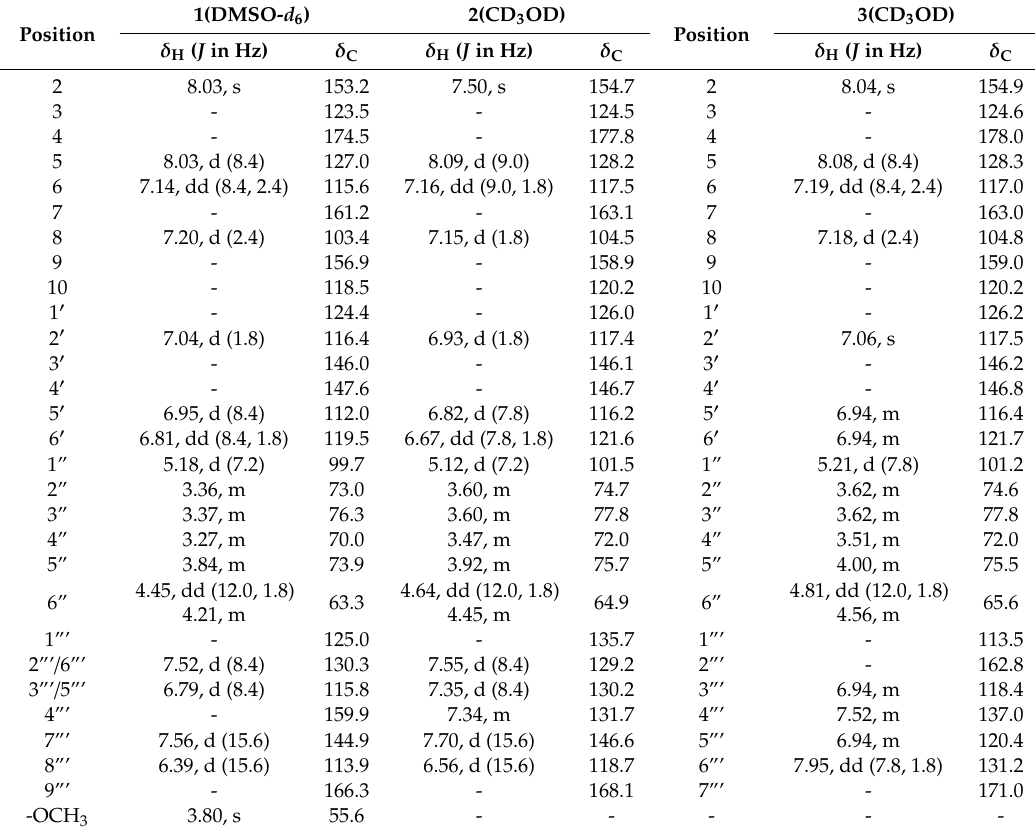
Table 1. 1 H NMR data (600 MHz) and 13 C NMR data (150 MHz) of compounds 1 , 2 and 3